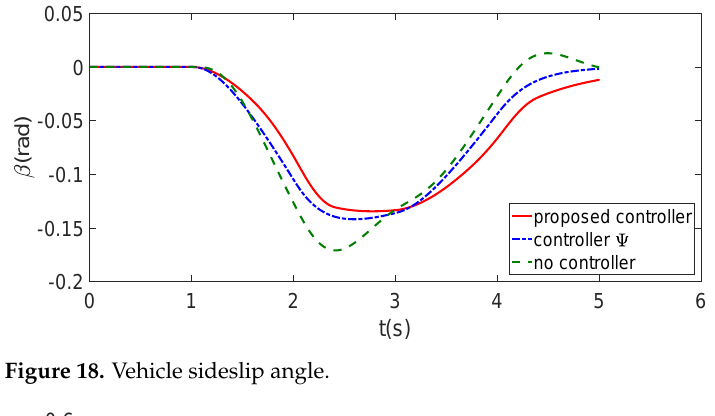
Figure 18. Vehicle sideslip angle.